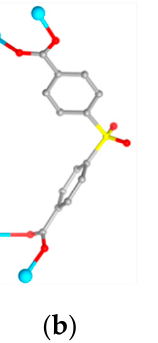
Scheme 1. Coordination mode of ptptp 2 − ( 1 and 2 , for ( a )), sdba 2 − ( 1 , for ( b )), and cpop 3 − ( 2 , for ( c )) ligands, color code: C gray, N blue, O red, S yellow, Mn turquoise. ( c )) ligands, color code: C gray, N blue, O red, S yellow, Mn